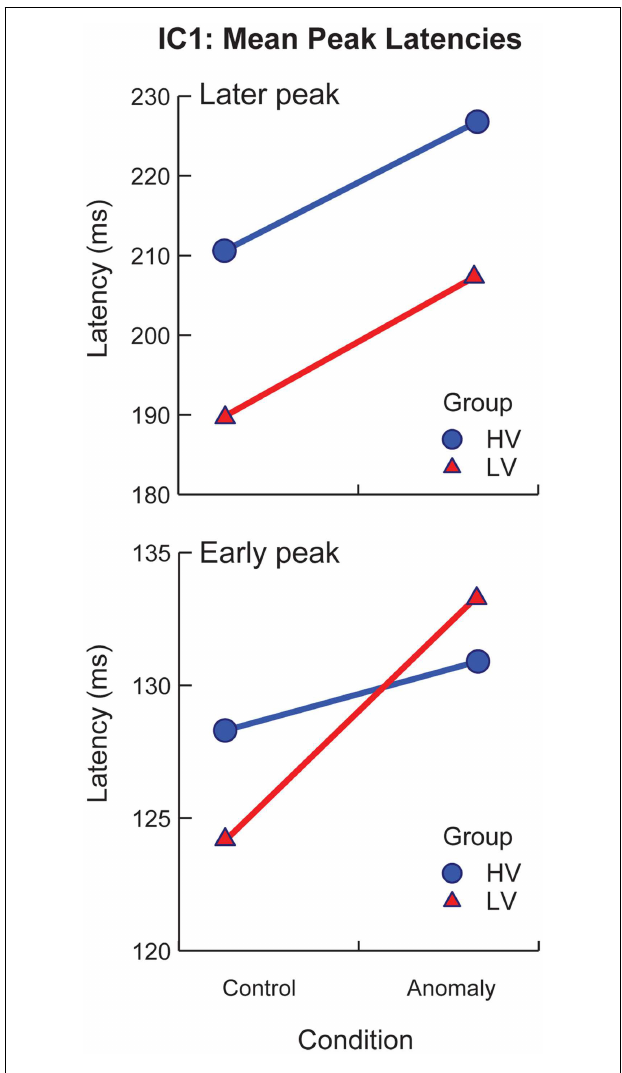
FIGURE 5 | Mean latencies for peak activation of IC1 by stimulus variability group (low-variability vs. high-variability) and sentence-type (control vs. anomaly) . Error bars represent standard